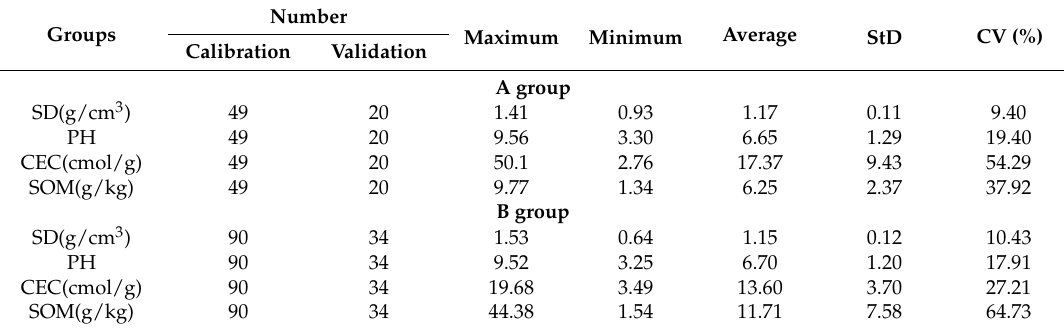
Table 2. Statistical description of soil properties in soil samples for groups A and